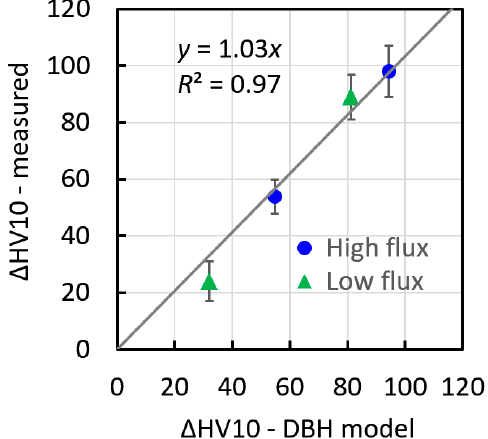
Figure 10. Comparison of the Vickers hardness increase estimated within the DBH model, Equation (1), with the measured Vickers hardness increase for the four RPV materials covered in this study. The triangles (dots) refer to the base (weld) materials.